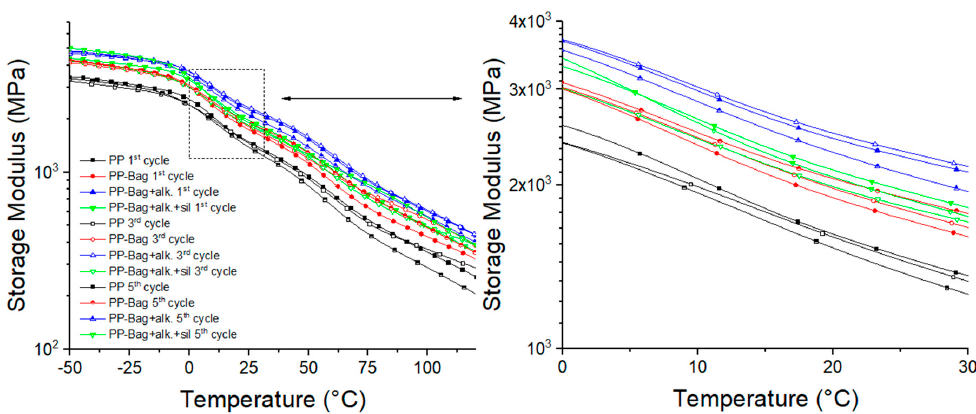
Figure 13. Temperature dependence of the storage modulus of PP and their biocomposites.